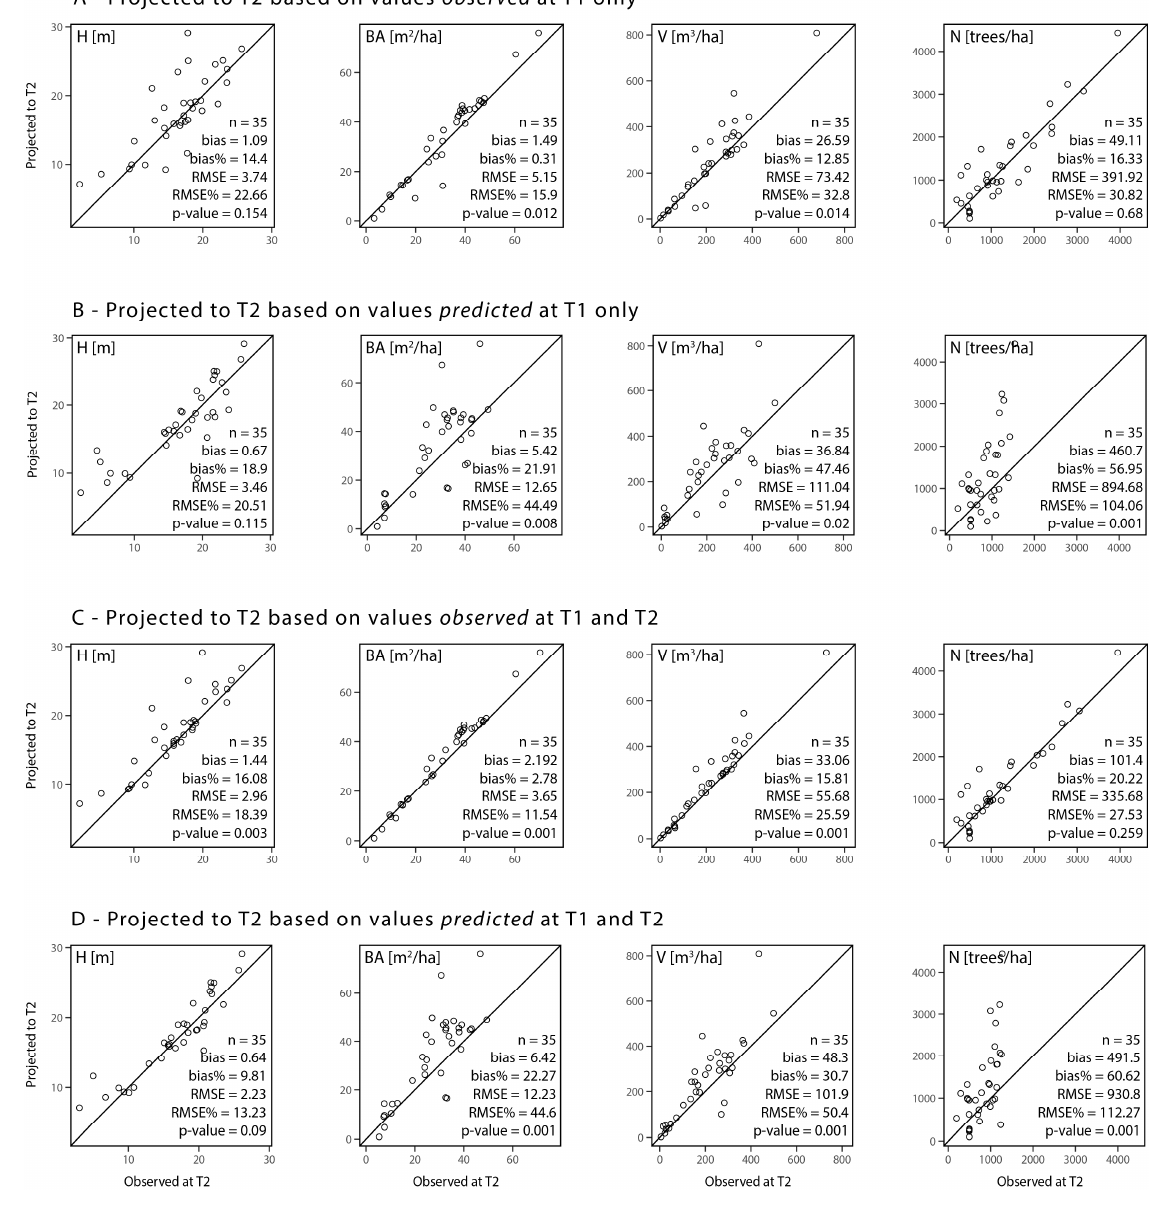
Figure 6. Scatterplots of stand attributes observed at T2 versus projected to T2 based on different projection approaches. H—top height, BA—basal area, V—total volume, N—stem Table 5. Multiple regression analysis of the curve matching error.